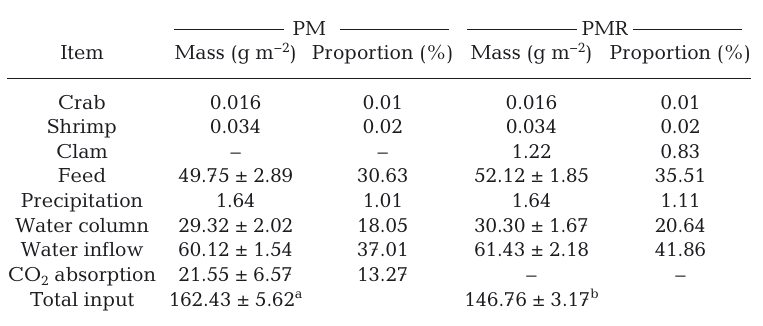
Table 3. In PM, water discharge and the water col- umn were the main output items, accounting for 48.99 and 40.18%, respectively. The carbon outputs emissions and in the form of harvested animals, CH 4 sediment accumulation represented small parts, ac - counting for only 5.71, 0.10 and 5.02%, respectively. Table 2. Carbon input in the 2 polyculture systems (PM and PMR, defined in Table 1) during the farming season. The values for mass are means ± SD (n = 3) and the values for proportion are presented as means (n = 3). Data in the same row with different superscripts indicate significant differences (p < 0.05)